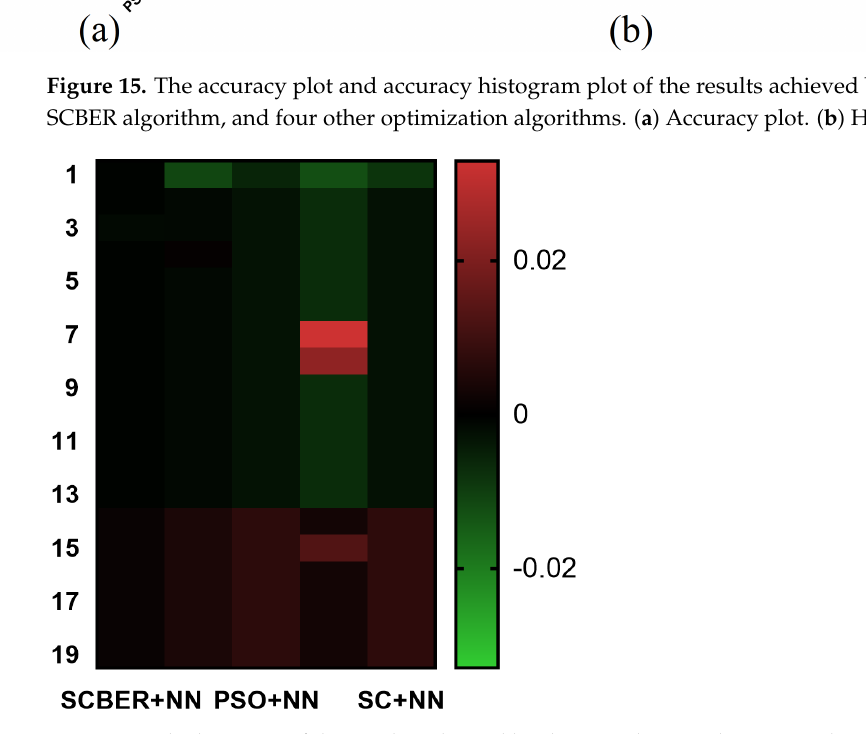
Figure 16. The heatmap of the results achieved by the neural network optimized using the proposed SCBER algorithm compared to the other competing